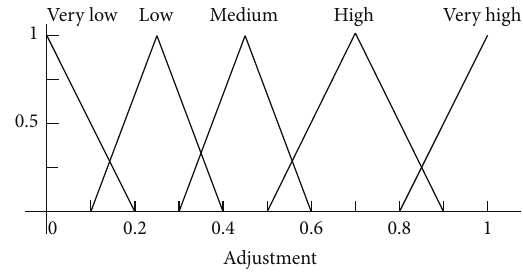
Figure 5: Fuzzy membership function for output variable.